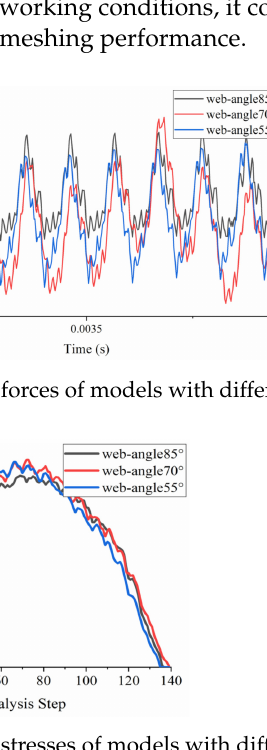
Figure 9. Contact stresses of models with different web support angles.